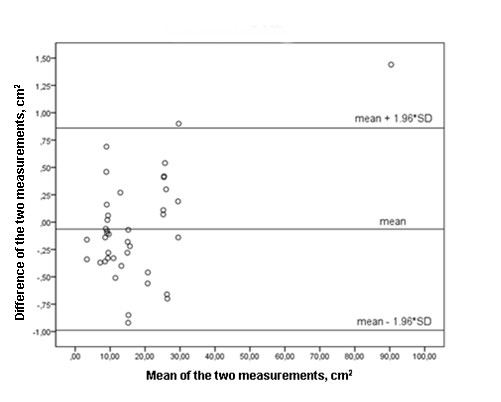
Bland-Altman plot with 95% limits of agreement for interobserver measurement variability (measurement of the non aerated dependent lung sonographic area, cm2).